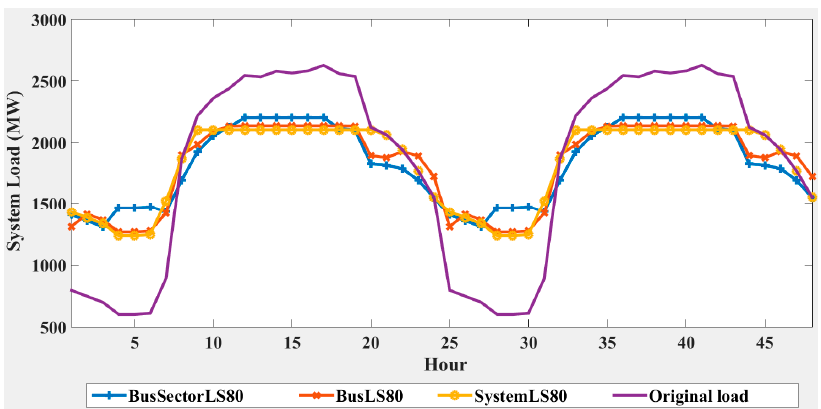
Figure 4. The 48-h system load profile with 80% pre-specified peak.